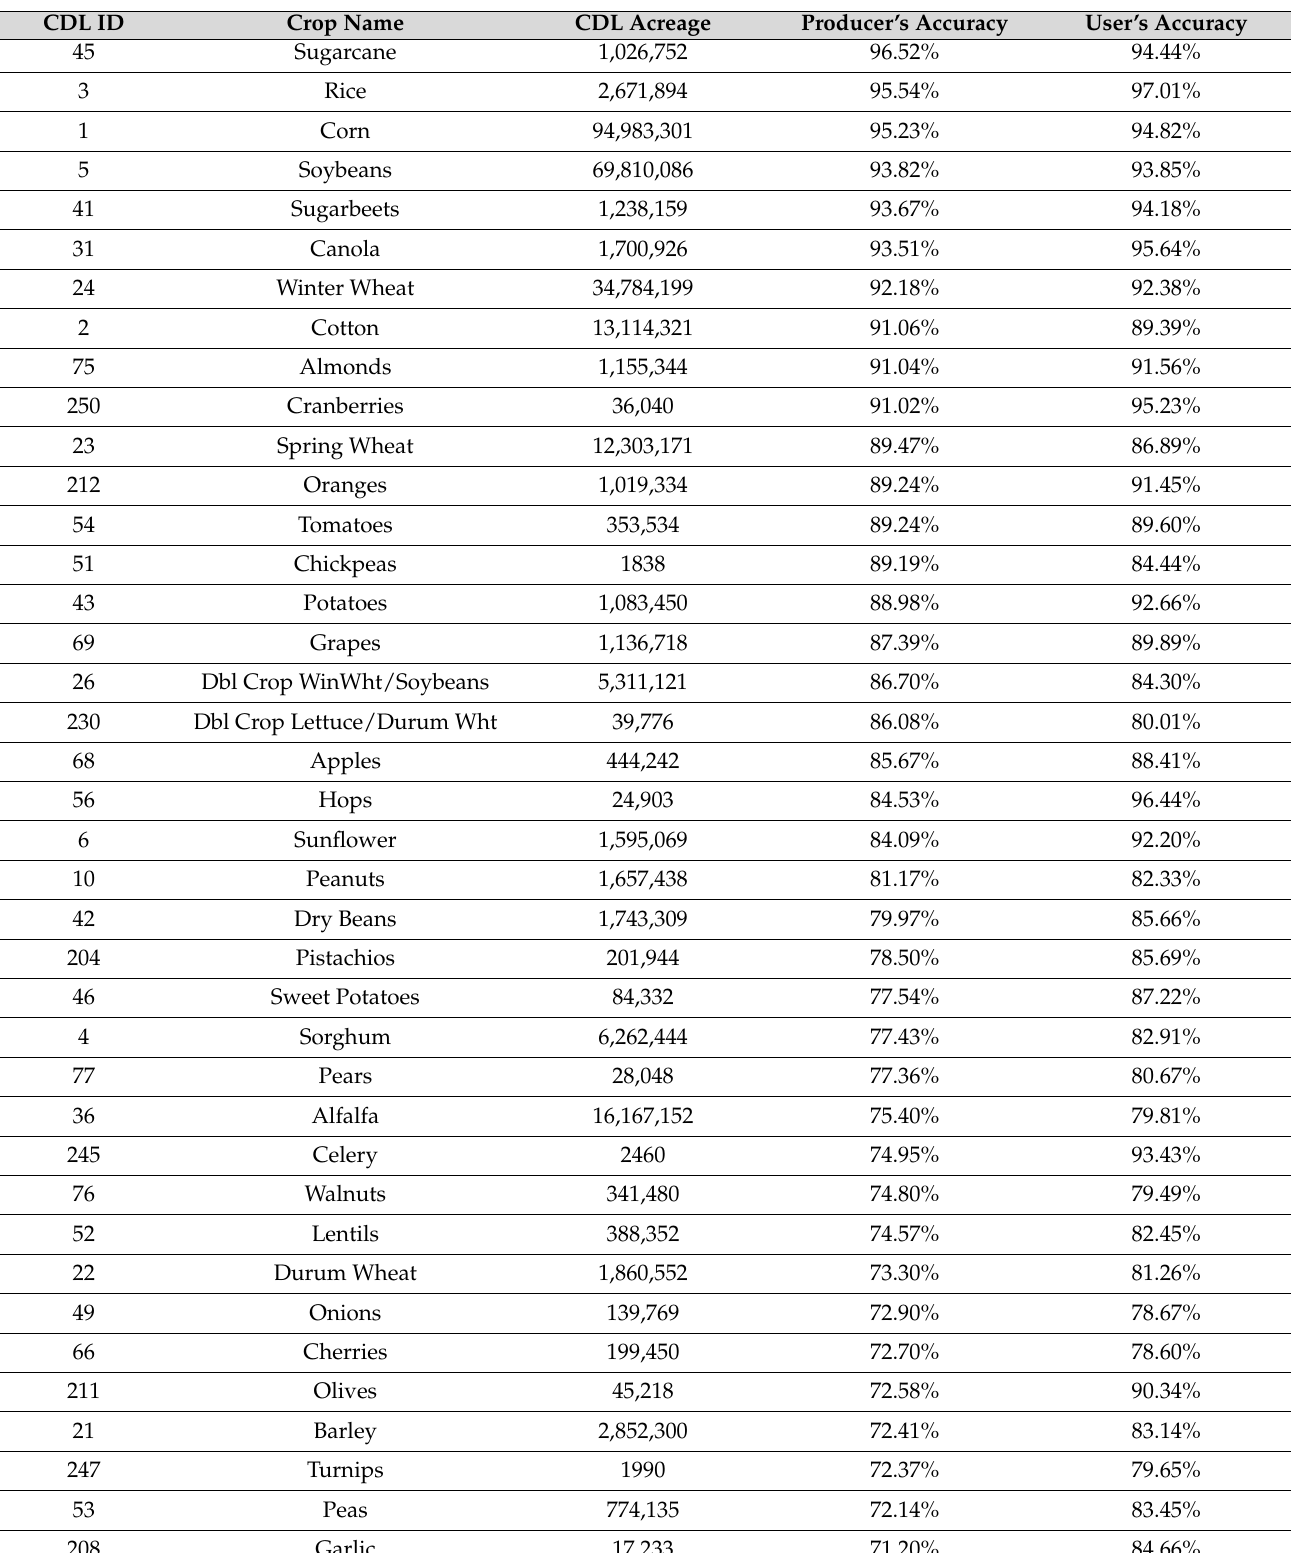
Table A2. Nationwide area, producer’s accuracy, and user’s accuracy for each crop type in the 2012 CDL. Sorted in order of descending producer’s